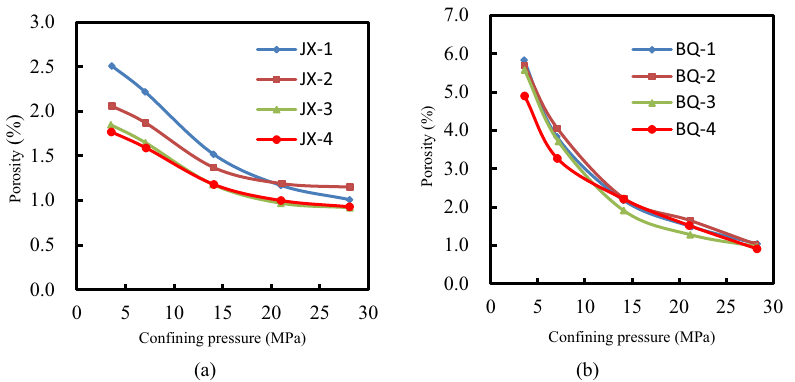
Figure 1. The relationship between porosity and net confining stress.